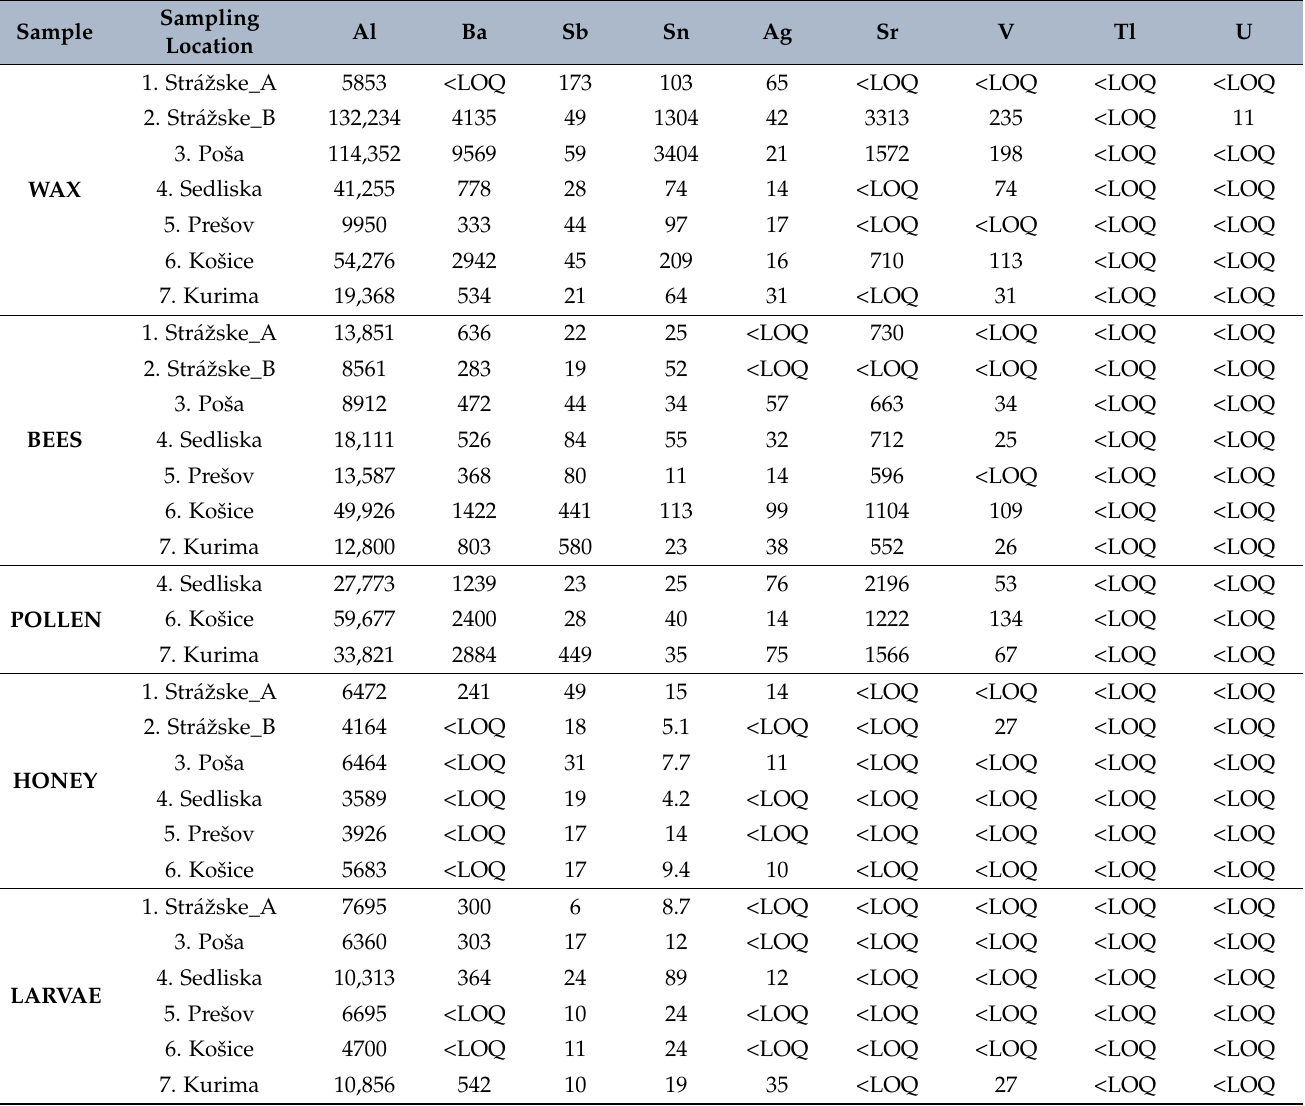
Table 2. Content ( µ g/kg) of other trace